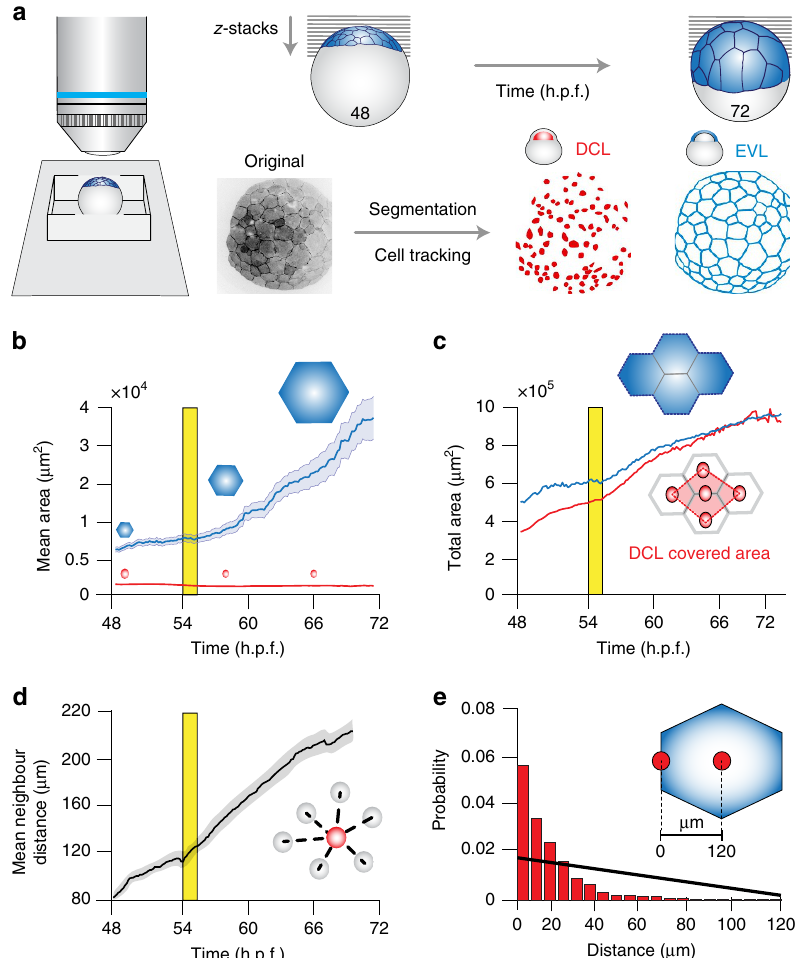
Figure 2 | Dynamics of tissue spreading of the embryonic DCL and its relation to the surface expansion of the extra-embryonic EVL. ( a ) Schematic diagram of in vivo imaging approaches. Embryos of A. nigripinnis expressing lifeact-GFP were imaged from the animal pole by 4D confocal microscopy between late blastula (48 h.p.f.) and 60% epiboly (72 h.p.f.), and cells of the DCL and EVL segmented and tracked over time. ( b ) Temporal changes in the mean surface area of EVL and DCL cells, with values expressed as means ± s.e.m. The blue polygons and red circles above the curves depict representative EVL and DCL cells drawn to scale, respectively. ( c ) Temporal changes in the total area covered by the EVL and the convex area covered by the underlying DCL cells, measured as indicated in the top and bottom insets, respectively. ( d ) Temporal changes in the mean distance to the six nearest neighbours within the DCL, with values expressed as means ± s.e.m. ( e ) Probability distribution of DCL cell position as a function of the distance to EVL cell borders, for the period between 30 and 60% epiboly (54–72 h.p.f.). The black straight line corresponds to the expected random distribution for a mean EVL cell surface radius of 120 m m, as indicated in the top right corner. In all panels, red and blue colours correspond to the DCL and EVL, respectively. The vertical yellow line in b – d indicates the onset of epiboly, defined by the initial vegetal-ward movement of the EVL epithelial margin. All panels of this figure were obtained after tracking and analysis of the entire set of EVL and DCL cells from Supplementary Movie 1. This analysis was replicated in a second embryo (Supplementary Fig.